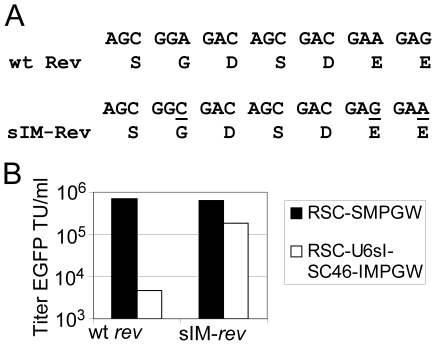
Production of tat/rev shRNA-containing lentiviral vectors at high titer using a modified helper plasmid.(A) Three synonymous mutations indicated by an underline were introduced into rev in the lentiviral helper plasmid pCMVRdelta8.74 which expresses Gag-Pol and Rev to create pCMVRdelta8.74-sIM, which contains three mismatches at the tat/rev site I shRNA target sequence. (B) Lentiviral vectors were prepared by transient transfection using either the lentiviral helper plasmid pCMVRdelta8.74, which contains the wild-type rev sequence (wt-rev), or the pCMVRdelta8.74-sIM helper, which contains the mutated (sIM-rev) and titered using the EGFP reporter. The RSC-UsI-SC46-IMPGW vector containing the tat/rev shRNA is produced at low titer using the wt rev helper, but is produced at 38-fold higher titer using the sIM-rev helper.